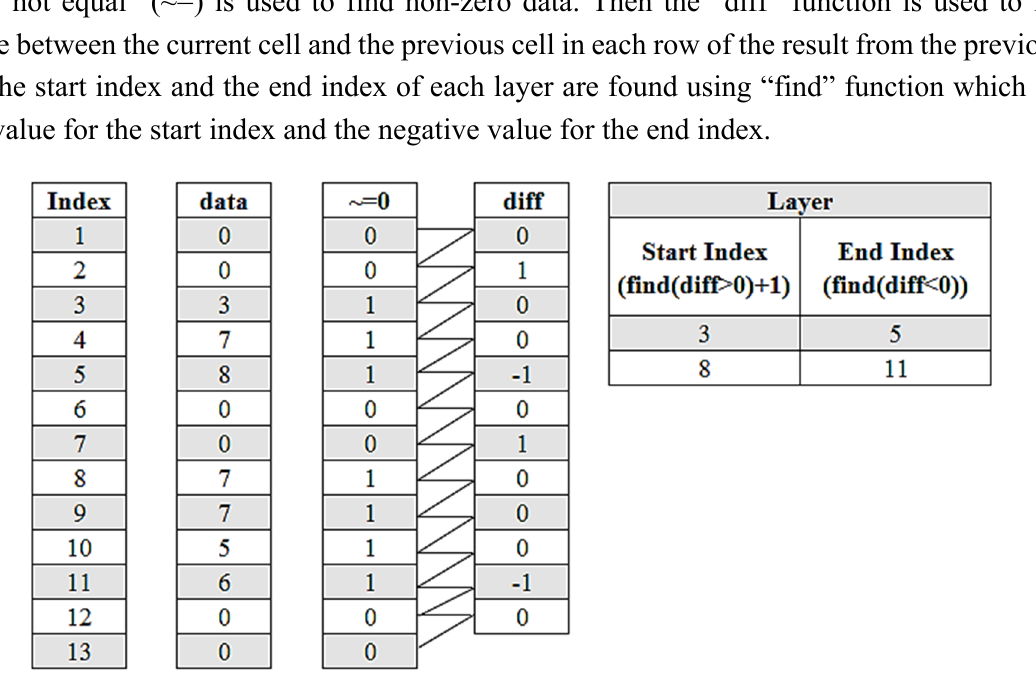
Figure 5. Layers